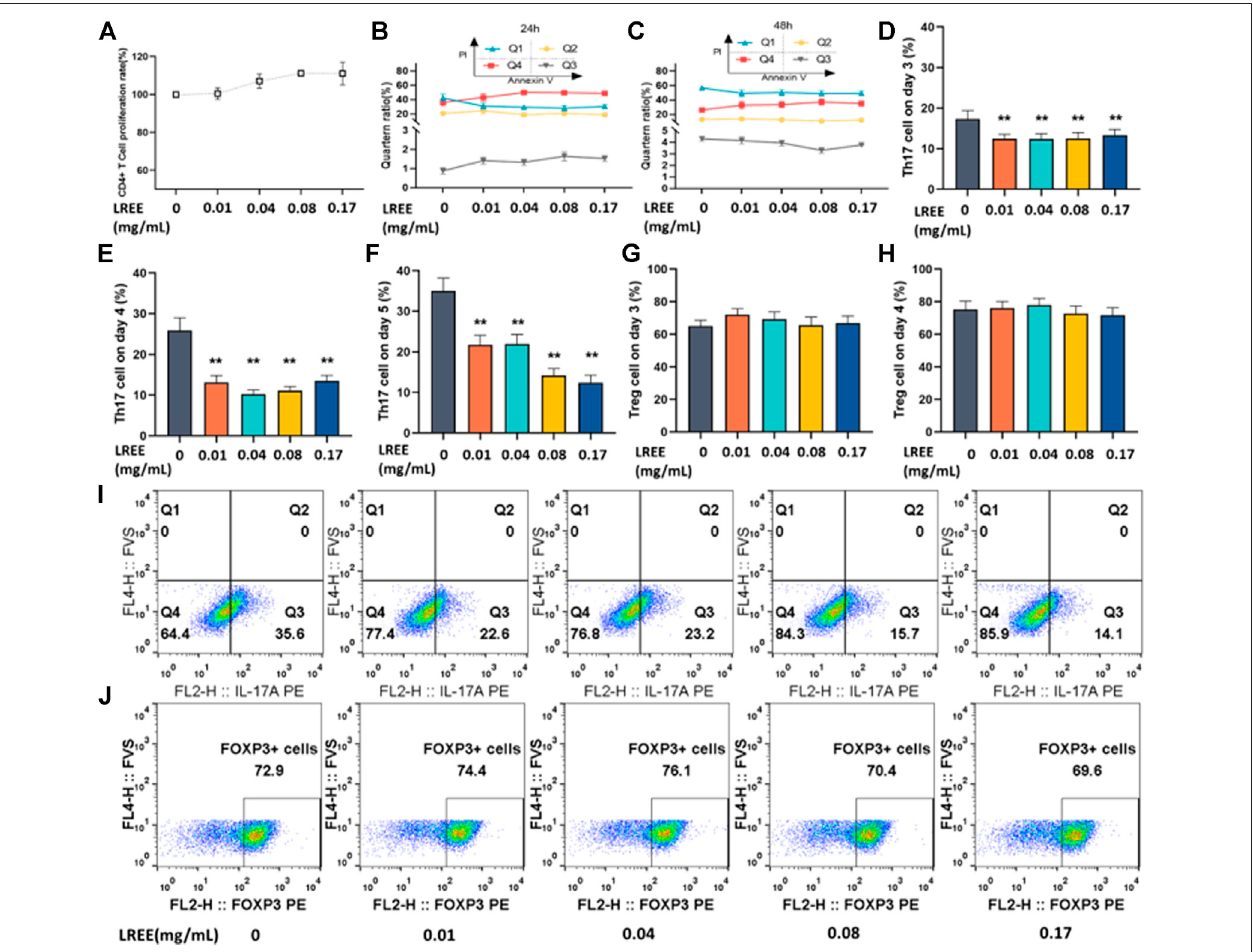
FIGURE9| EffectsofLREEonTh17andTregcellsdifferentiation invitro ( n (cid:2) 3). (A) TheproliferationrateofCD4 + Tcellsstimulatedwithanti-CD3/CD28for24 hby CCK-8 assay. (B, C) The cell viability of CD4 + T cells stimulated with anti-CD3/CD28 antibodies using Annexin V/PI apoptosis assay by fl ow cytometry. (D – F) Statistical analysis of the differentiation ratio of Th17 cells from day 3 to day 5. (G, H) Statistical analysis of the differentiation ratio of Treg cells on day 3 and day 4. (I, J) Representative pseudocolor dot plots of proportion of Th17 and Treg cells detected by fl ow cytometry. * P ＜ 0.05, ** P ＜ 0.01 vs. blank control (none-LREE- treated)